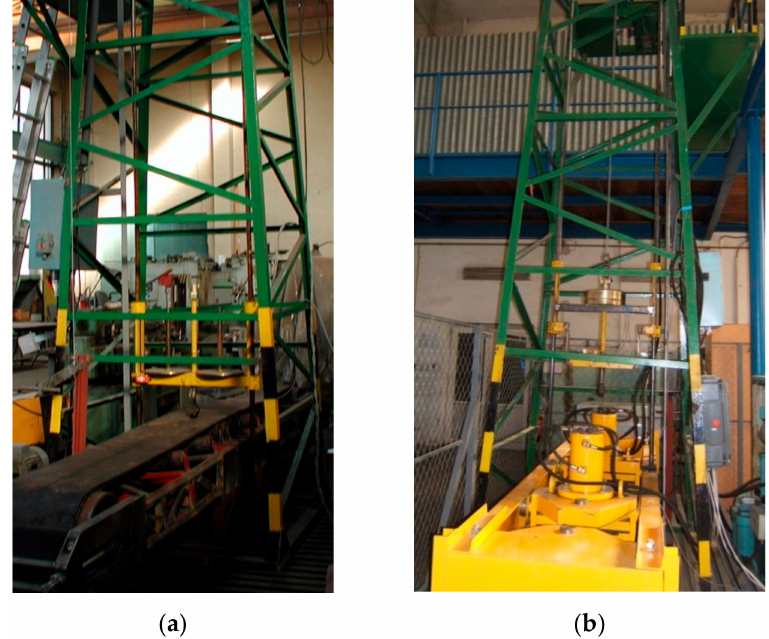
Figure 4. Test equipment: ( a ) original stand [28]; ( b ) innovated stand.